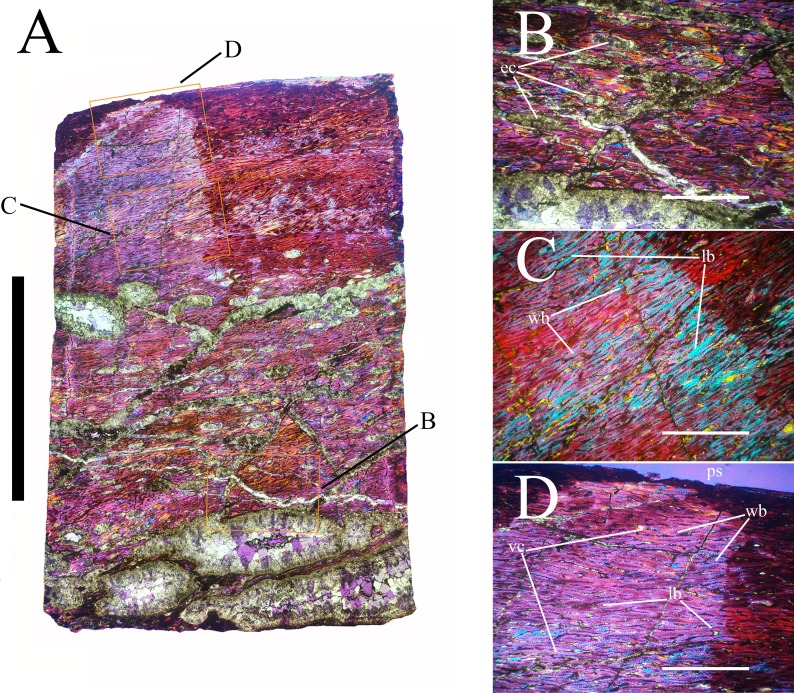
MSNVE 3714, right femur, thin section.Panoramic view under lambda filter (the outer surface of the bone is at the top of the figure) (A); the gradual transition between the compacta and the medullary cavity made of CCB and erosional cavities (B); detail of the plexiform vascularization and fibrolamellar bone forming the primary bone and the absence of zonation and LAGs within the compacta (C); detail of the microstructure of the outermost cortex showing the absence of an EFS (D). Abbreviations: ec, erosional cavities; lb, lamellar bone; ps, periosteal surface; vc, vascular canals; wb, woven bone. Scale bars equal 10 mm in A and 1 mm in B–D.